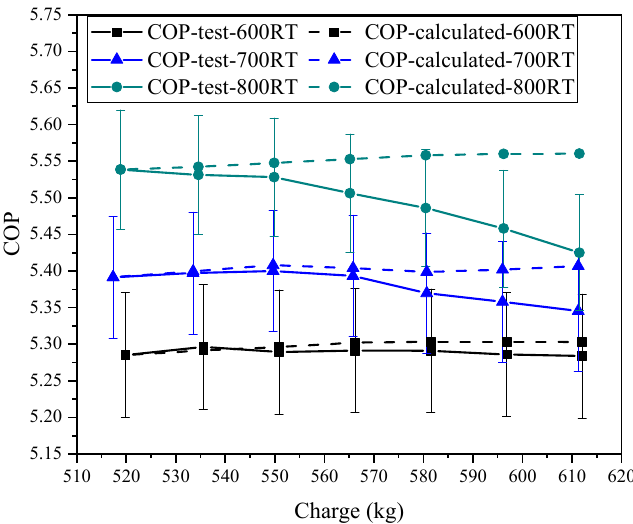
Figure 11. Test and calculated COP as a function of charge at each